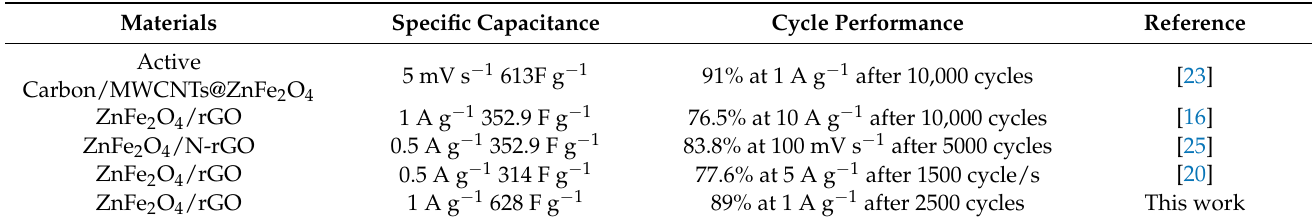
Table 1. The comparison with previously reported ZnFe 2 O 4 -based supercapacitor